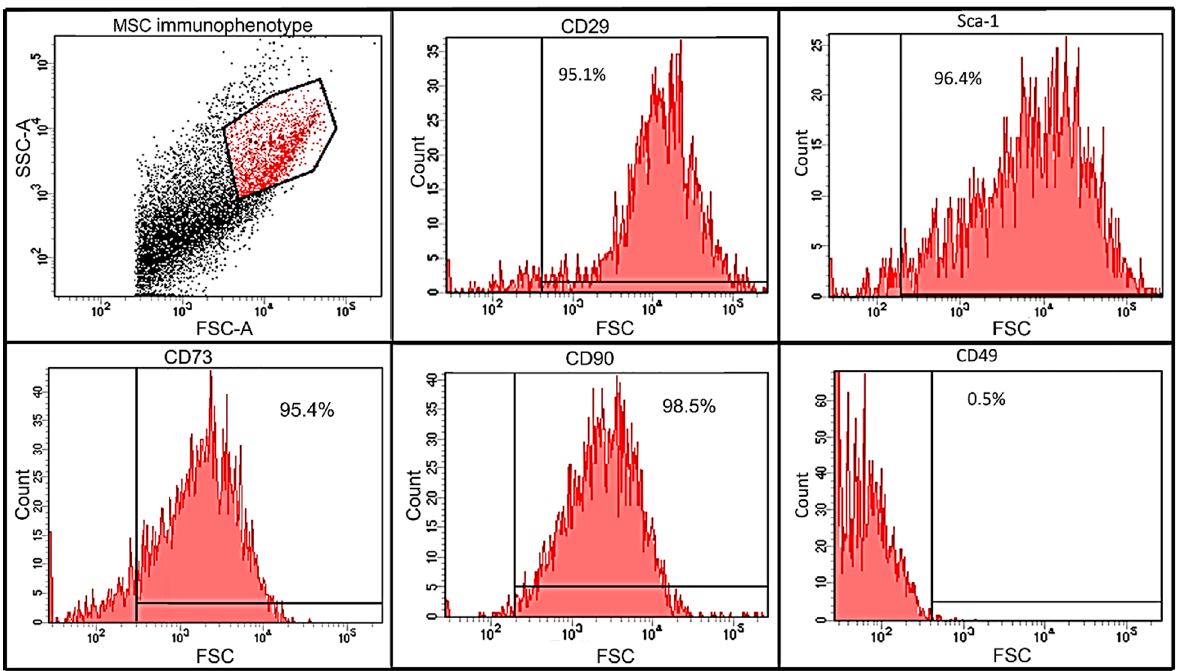
Figure 1. Immunophenotyping analysis of adipose-tissue-derived mMSCs by flow cytometry. Adipose-tissue-derived mMSCs were incubated in anti-mouse-CD29-PE, anti-mouse-Sca-1-AmCyan-A, anti-mouse CD90-BV421, anti-mouse-CD49-PE, and anti-mouse CD73-Alexa Fluor 647 antibodies. Cells were analyzed using flow cytometry on a FACS Aria III (Becton, Dickinson and Company, Becton Drive Franklin Lakes, Franklin Lakes, NJ, USA). A minimum of 300,000 events were collected for each sample. Results represent the percentage of cells expressing the surface markers.